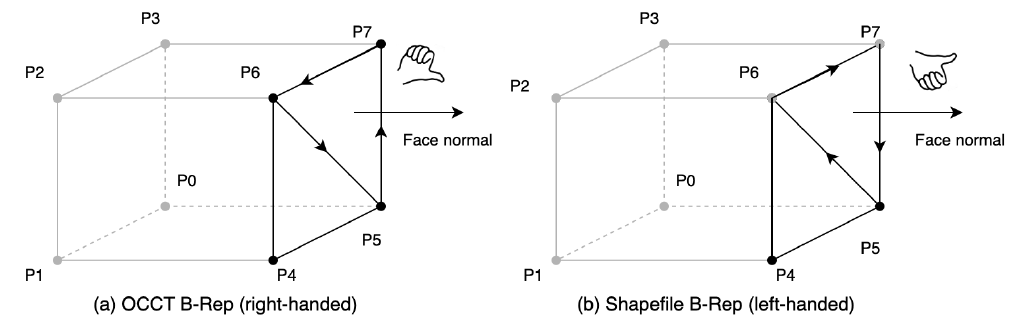
Figure 7. Normal of face (outward) in OCCT B-Rep and shapefile B-Rep. The algorithm for converting OCCT B-Rep into shapefile B-Rep is graphically pre- sented in Figure 8. In this algorithm, an object from IFC is first converted using OCCT into temporary shape objects. Then, from the shape objects, a point list ( 𝑃 ) is derived from the coordinate list ( 𝐿1 ), and a face list ( 𝐹 ) is obtained from the point index list for face ( 𝐿3 ), and, finally, the shapefile B-Rep is generated from the point list ( 𝑃 ) and the face list ( 𝐹 ).